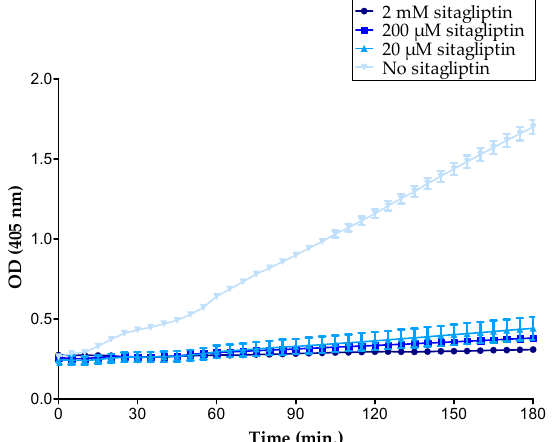
Figure 6. Sitagliptin inhibits CD26 proteolytic activity on T cells. In total, 3 × 10 6 cells per mL were incubated with 500 µ M Gly-Pro-pNA with or without 20 µ M to 2 mM sitagliptin in 75 mM Tris-HCl buffer (pH 8.3). OD values were measured at 405 nm and plotted in function of time to construct CD26 activity curves. The figure shows mean values (±SEM) of a representative experiment. Int. J. Mol. Sci. 2017 , 18 , 1513